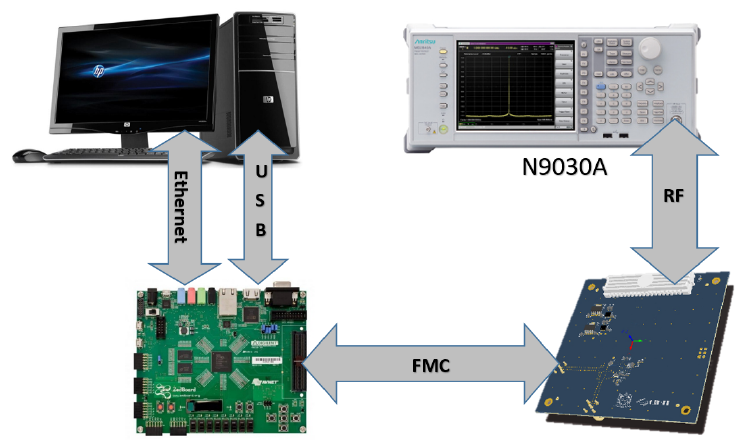
Figure 8. Testbed block diagram. Configuration for the connection of the test bed for the